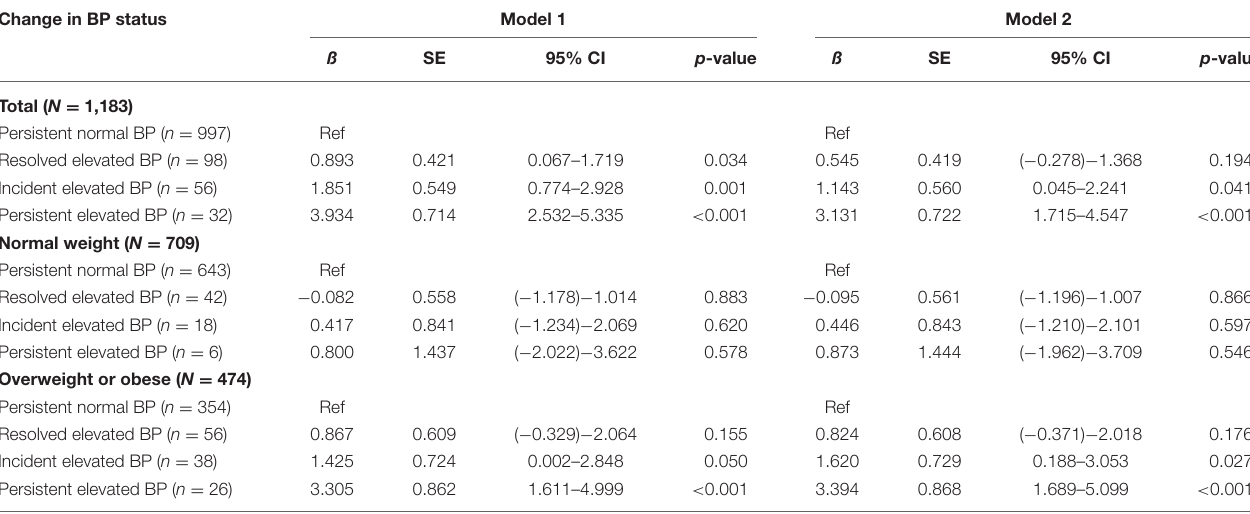
TABLE 3 | Association of change in BP status with LVMI at follow-up in the total sample and stratified by weight